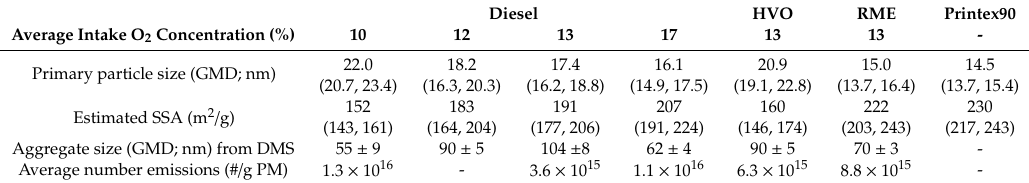
Table 2. The geometric mean of the soot primary particle size measured from the TEM images, the estimated specific surface area (SSA), the mobility size of the aggregates (geometric mean diameter ± 1 std. dev. in the time series) measured with the DMS and the average number concentration per gravimetric PM mass. The GSD for the primary particle size and SSA distributions were 1.32–1.50. For primary particle size and SSA, intervals in brackets represent the 95% confidence interval of the distribution parameters.